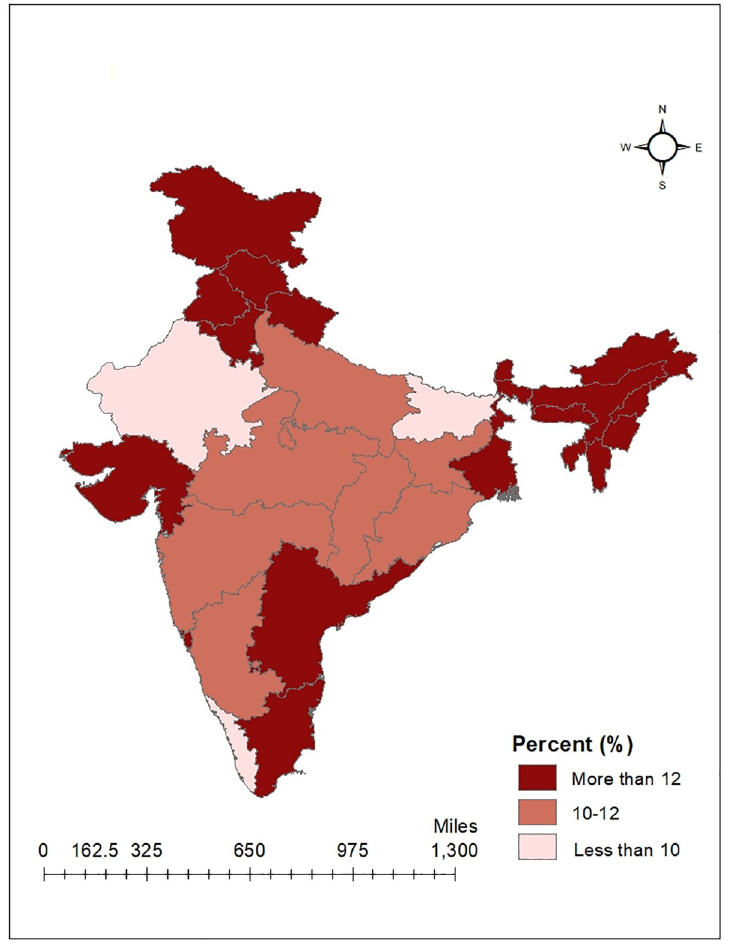
Fig 1. Prevalence of hypertension among women by states of India,